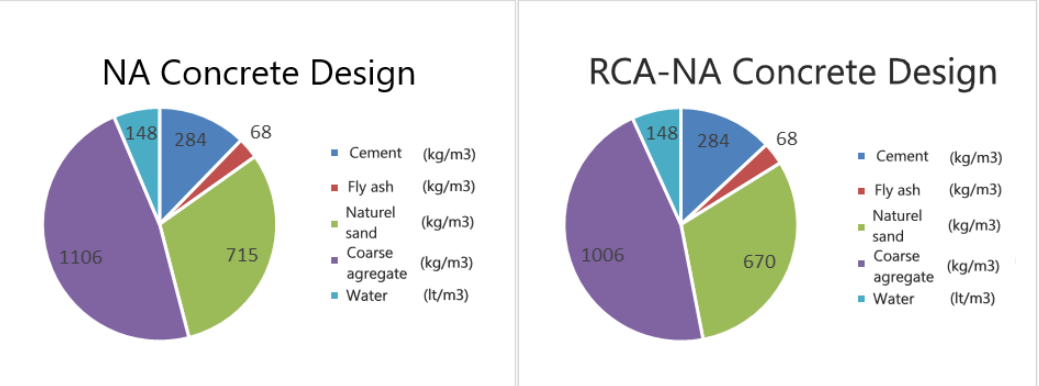
Figure 3. Concrete mixture amounts of materials according to NA and RCA-NA usage